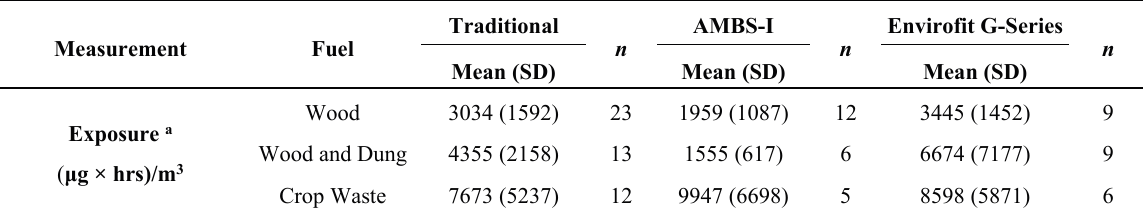
Table A3. Summary of exposure in Study I comparing two alternative cookstoves to a traditional stove in a home setting in rural Nepal .